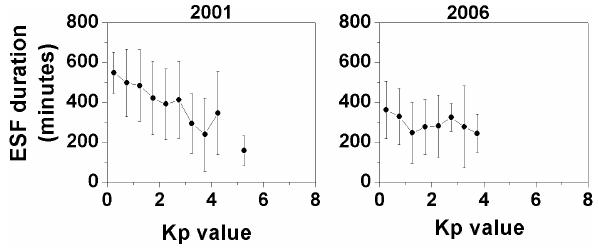
Fig. 3. Plot of the average ESF duration, with the standard devia- tion, against the magnetic activity index K p , taken in intervals of 0.5, for the solar maximum and minimum years of 2001 and